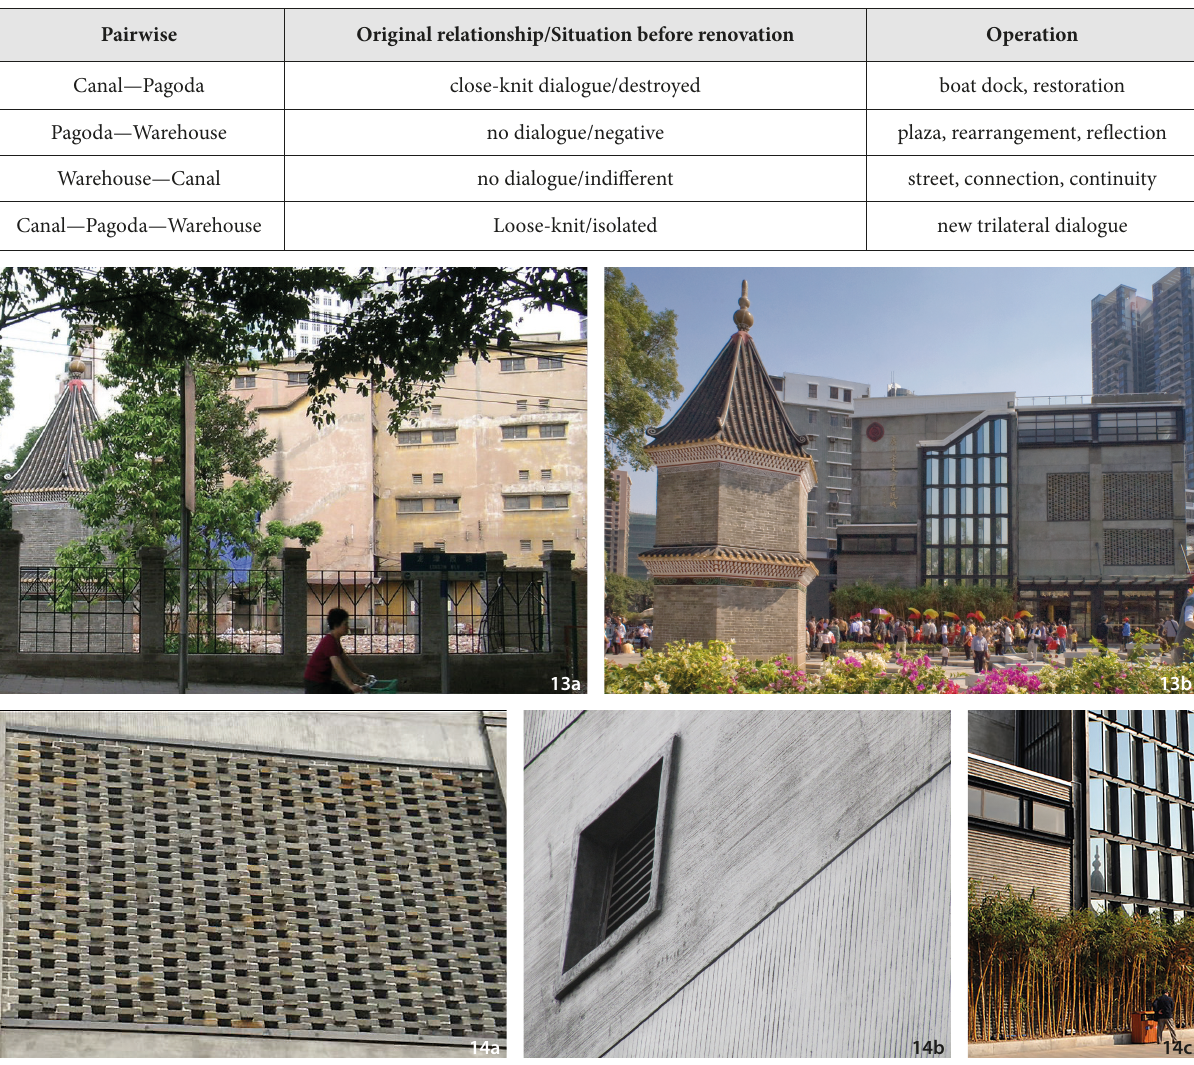
Figure 13a The pagoda and warehouse before renovation (Source: Jiang Feng). Figure 13b The pagoda and warehouse after renovation (Source: Yuanxiang Luo). Figure 14 Details of the façade of Lungchun Warehouse (Source: a, b: Jiang Feng; c: Yongjian